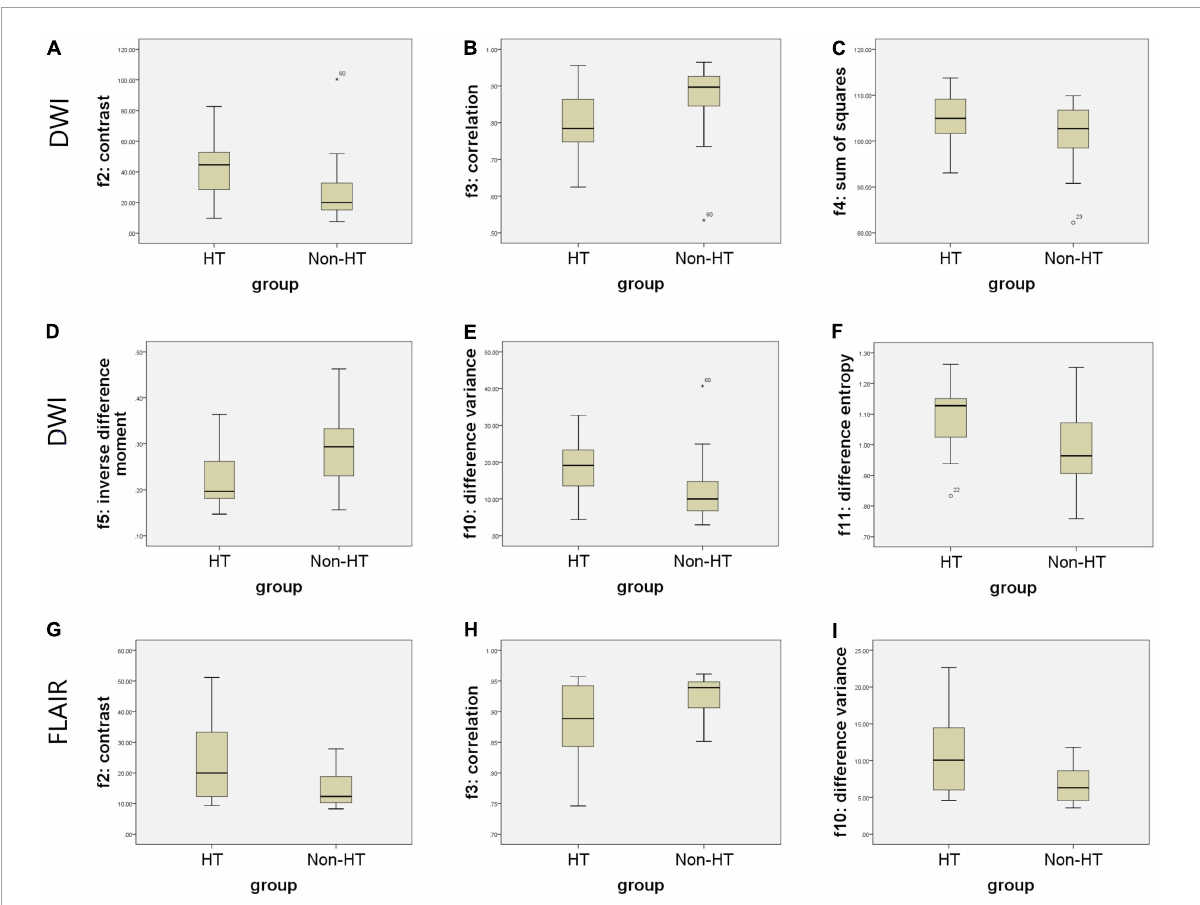
FIGURE3 Boxplots of the most distinguishing texture parameters for predicting hemorrhagic transformation (HT) based on magnetic resonance (MR) images. Boxplots show six texture parameters (f2, f3, f4, f5, f10, and f11) with significant distinguishing capacity between infarct lesions of two groups for predicting HT based on diffusion weighted imaging (DWI) (A–F) . Boxplots show three texture parameters (f2, f3, and f10) with significant distinguishing capacity between infarct lesions of two groups for predicting HT based on T2-weighted-fluid-attenuated inversion recovery (T2/FLAIR) (G–I)